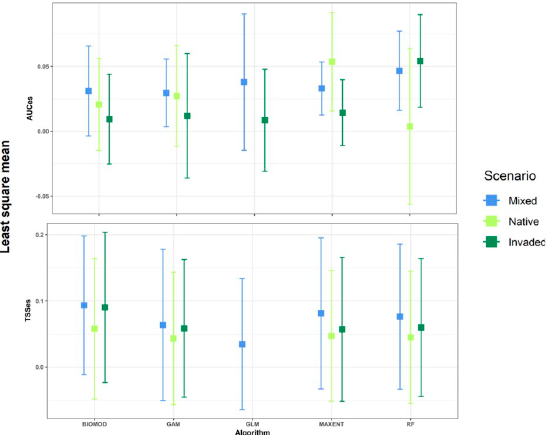
Fig 3. Meanvalues of AUCes and TSSes for the five algorithms with results and the three scenarios. Boxes indicate the least square means based on a linear mixed models considering Scenario and Algorithm. Error bars indicate the 95% confidence interval of the least square means.